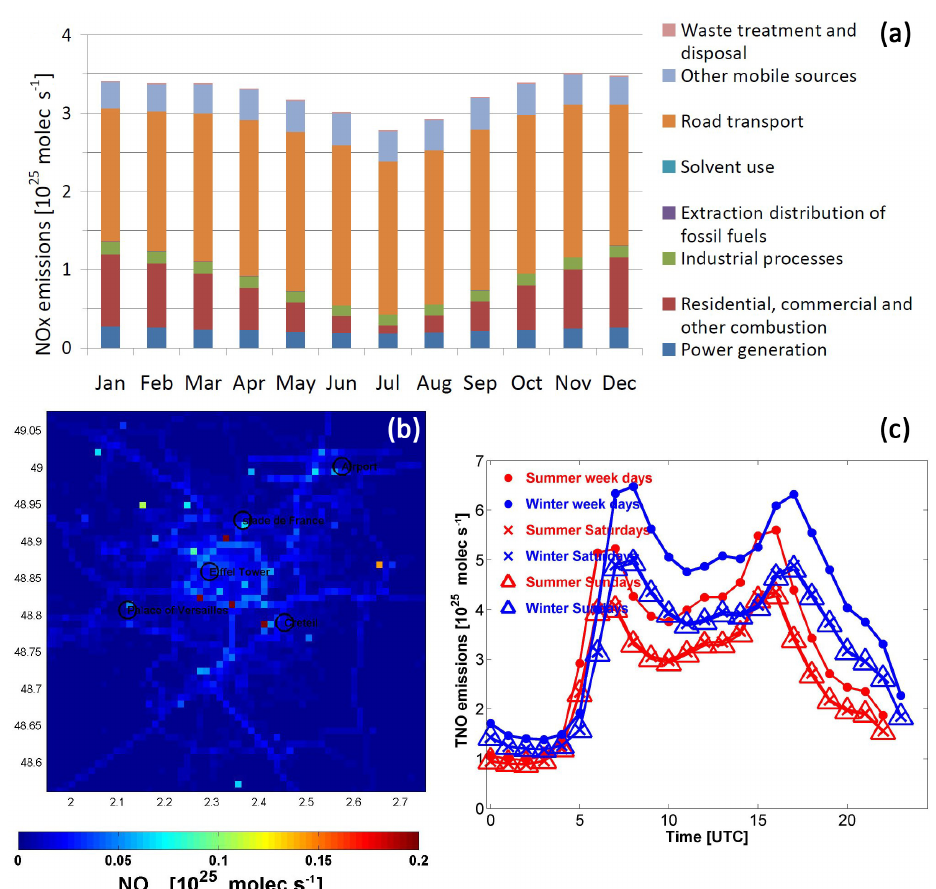
Figure 2. (a) Seasonal cycle of the NO x emissions for the greater Paris area (Île-de-France) in 2009 by source sector per month. Examples of the spatial distribution (b) and the diurnal variation (c) of the integrated NO x emissions over the area shown in (b) . For the Paris region the emission data are available at 1km resolution, but for the CHIMERE simulations they were summed up to the spatial resolution of the model (3km) (Airparif,